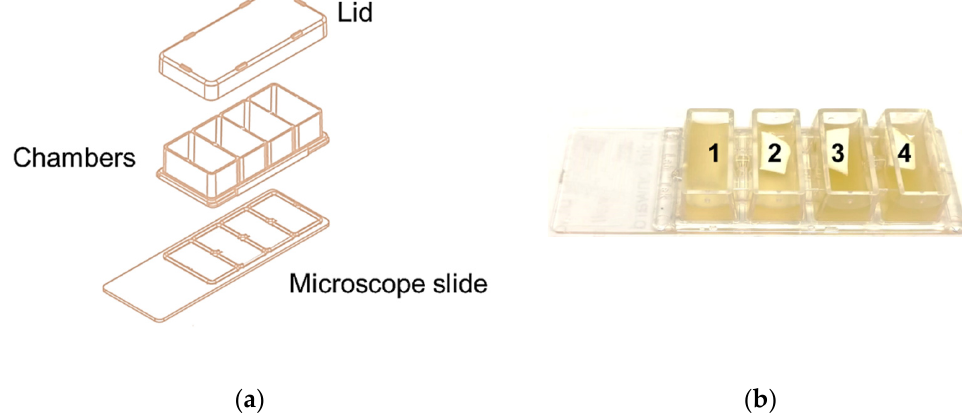
Figure 1. Chamber slide for biofilm analysis. ( a ) Structural components of cultural system. ( b )